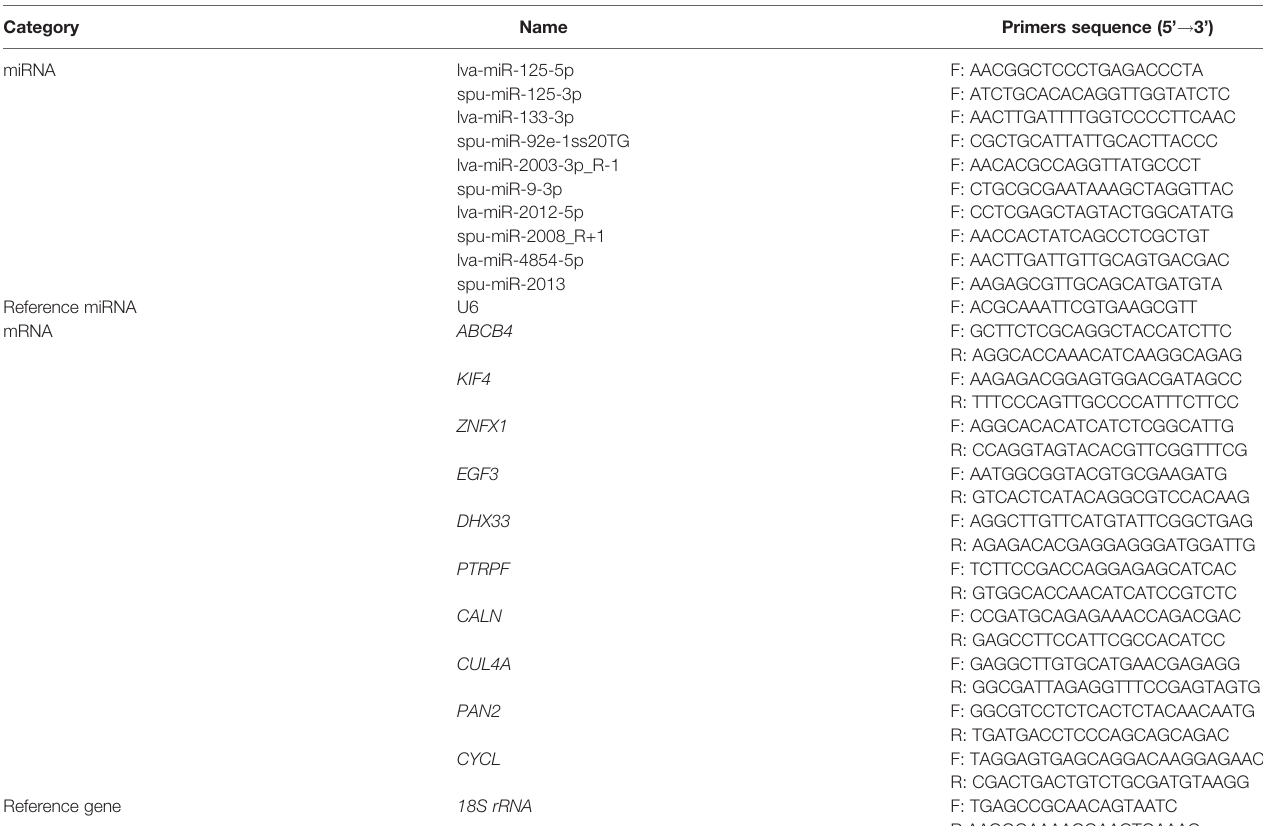
TABLE 1 | Primers used for DEMs and target DEGs veri fi